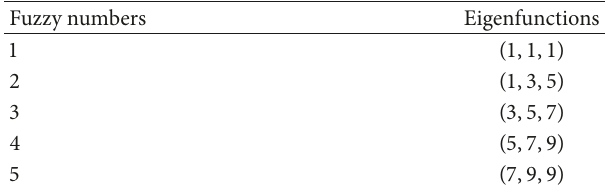
Table 3: Eigenfunction of triangular fuzzy numbers.